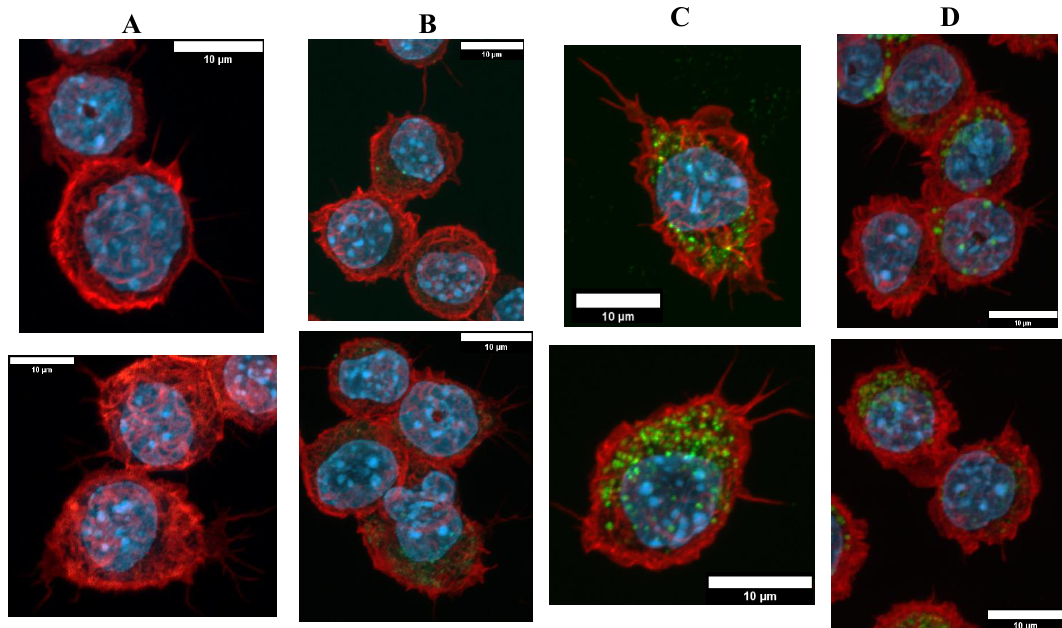
Figure 3. Green silica internalization and cytoskeleton changes of RAW264.7 cells after acute exposure. ( A – D ) Control and green silica internalization of cells exposed to 5 µg/mL, 20 µg/mL, and 30 µg/mL during 24 h, respectively, obtained by confocal microscopy (nucleus in blue (DAPI), actin in red (phalloidin), silica in green (FITC)), n = 2.